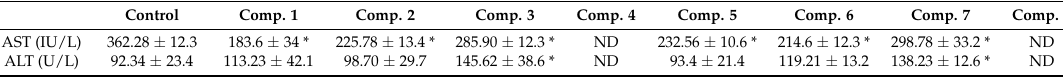
Table 4. Effect of SNEDDS containing P. lanceolata extract on serum AST and ALT enzyme activities. Each value represents the means ± SD for 6 mice and is expressed in IU/L or U/L. Groups treated with the compositions 1 – 8 were compared to the control group, significant differences were marked with an asterisk. Administration of compositions 4 and 8 resulted in the death of mice within 2 days (ND = No Data), (Comp. = Composition). Control Comp. 1 Comp. 2 Comp. 3 Comp. 4 Comp. 5 Comp. 6 Comp. 7 Comp. 8 AST (IU/L)